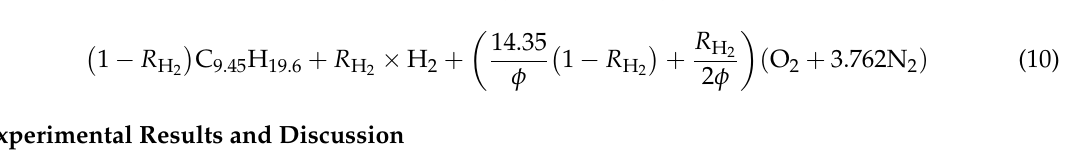
Aromatic hydrocarbons